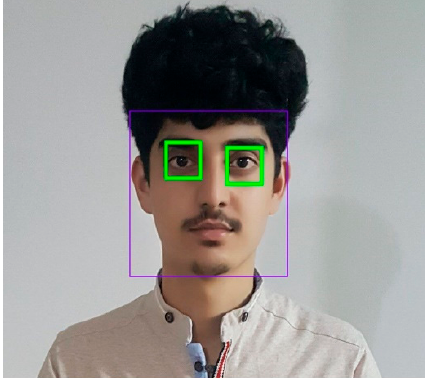
Figure 2. Gaze interaction and bounding box formation.